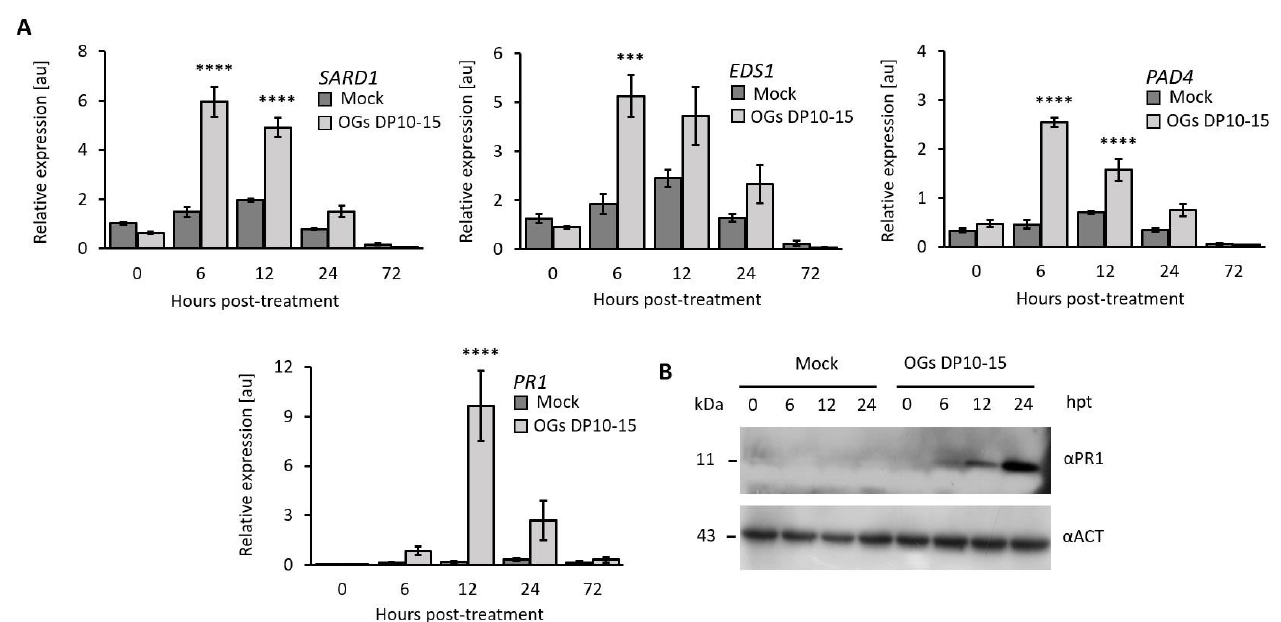
Figure 5. Treatment with OGs increases the expression of salicylic acid (SA)-related genes. ( A ) The transcriptional profile of SA-related genes in fully expanded leaves of 4-week-old Arabidopsis plants, treated with OGs (DP 10 – 15; 200 µg mL −1 ), at different post-treatment temporalities. Results are expressed as the relative expression in arbitrary units (au). The error bars represent standard error. Asterisks represent significant differences between mock- and OG-treated samples at the same tem- poralities as determined using the Student’s t -test (***, p < 0.001; ****, p < 0.0001; n = 4). ( B ) PR1 protein levels in mock- and OG-treated Arabidopsis leaves at different post-treatment temporalities analyzed using Western blot.